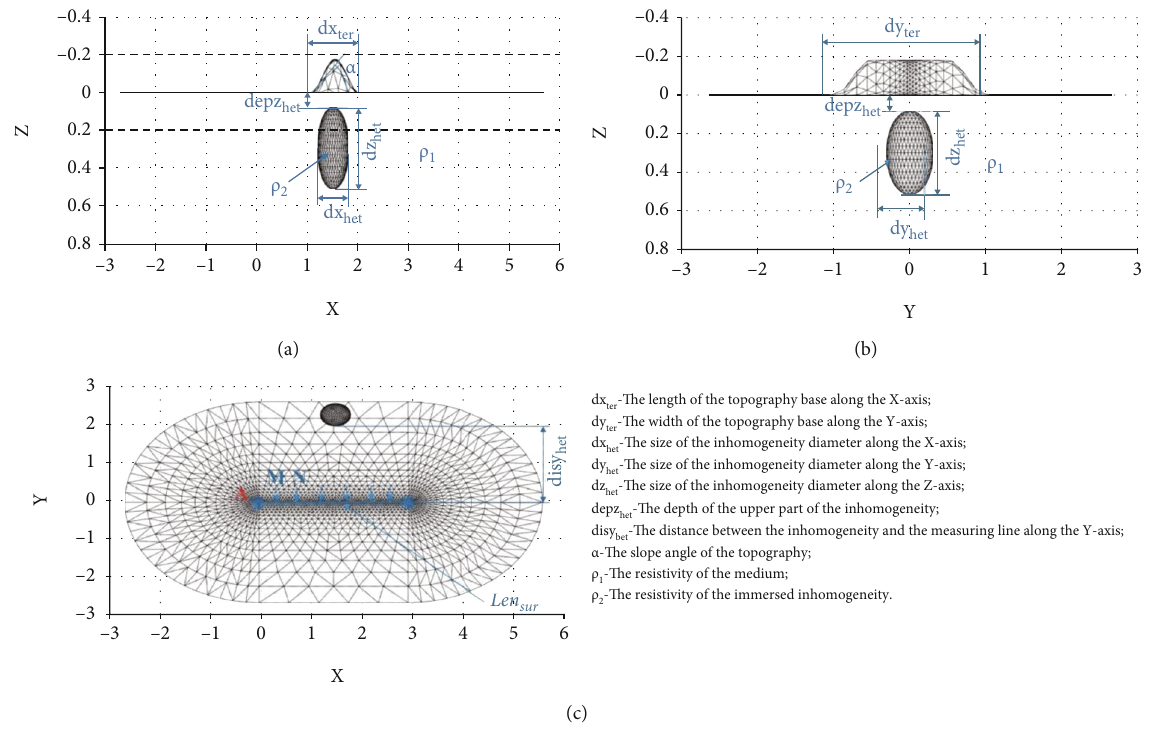
Figure 5: Computational mesh on the ground surface and immersed inhomogeneity surface. (a) XZ-section. (b) YZ-section. (c) Computational mesh on the ground surface in the XY-section (Bottom